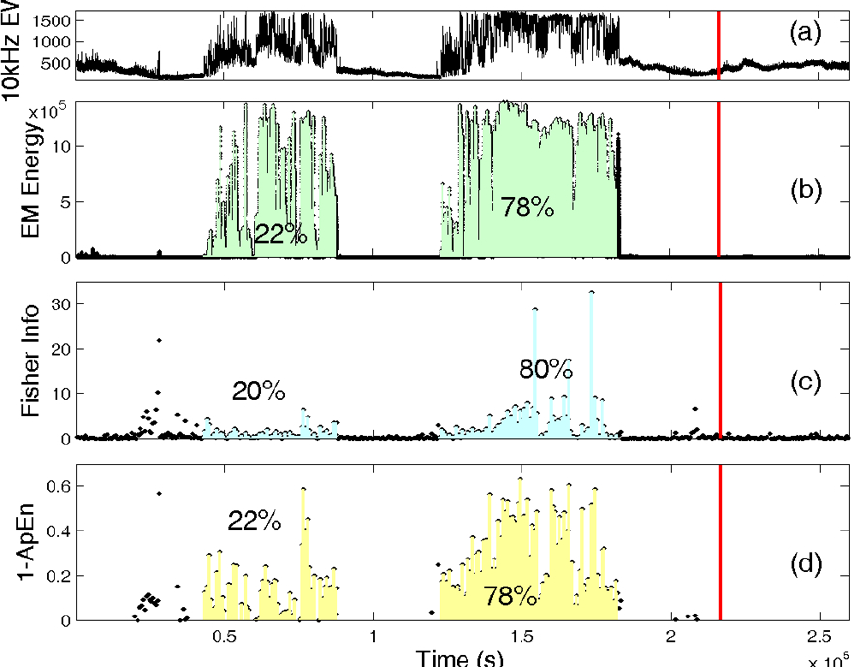
Fig. 6. (a) The two strong impulsive bursts in the tail of the recorded possibly EQ-relatedkHz EM emission (10kHz, East–West, magnetic field strength in arbitrary units) prior to Athens EQ (please refer to Fig. 4). For the specific signal excerpt, the EM Energy (in arbitrary units) (b) , the Fisher information (c) and approximate entropy (APEn) (d) evolution with time are presented. The light green, blue and yellow coloured areas indicate the energy, information and 1-ApEn corresponding to the two bursts, respectively. The first (left) burst is responsible for the 22% of the EM energy, the 20% of the Fisher information, and the 22% of the ApEn, while the second (right) for the 78%, 80%, and 78%, respectively. All graphs are time aligned, the vertical red line indicates the time of occurrence of the